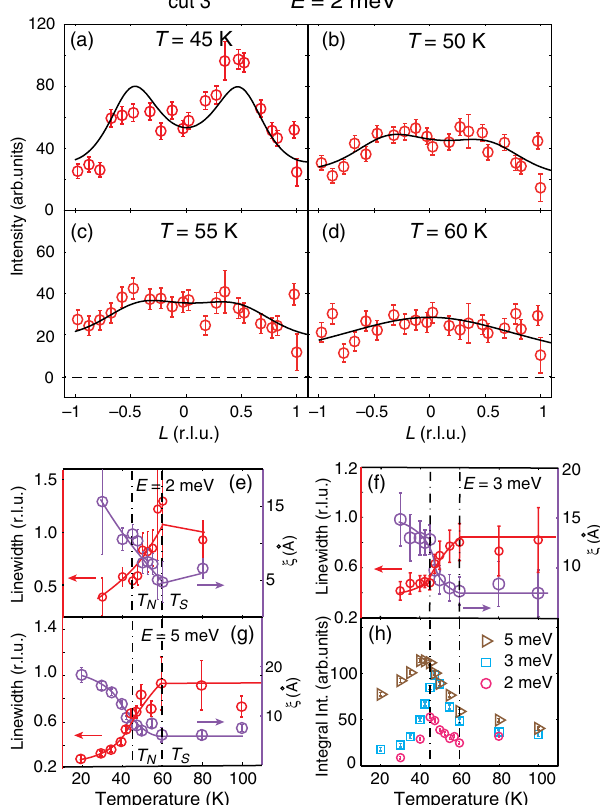
FIG. 4. (a) – (d) Constant- E ( E ¼ 2 meV) scans along the cut-3 direction as shown in Fig. 3(a) at 45 K, 50 K, 55 K, and 60 K. Background scans are obtained by measuring at q ¼ ð 0 . 4 ; 0 . 4 ; L Þ and ð 0 . 6 ; 0 . 6 ; L Þ and are subtracted from the raw data. The scan at 60 K is featureless. On cooling to 55 K, two weak peaks show up around L ¼ (cid:3) 0 . 5 r.l.u. Upon further cooling, these peaks become prominent at T ¼ 45 K. They disappear below T N due to the opening of a spin gap. The total magnetic scattering